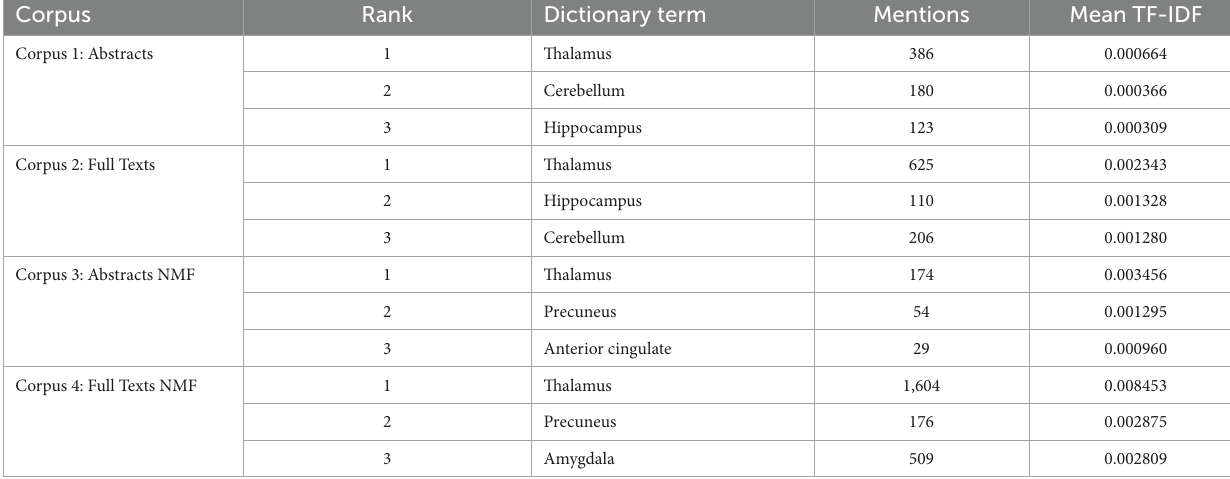
TABLE 2 Bibliometric search results highlighting the top 3 highest ranked brain regions in each corpus by TF-IDF.